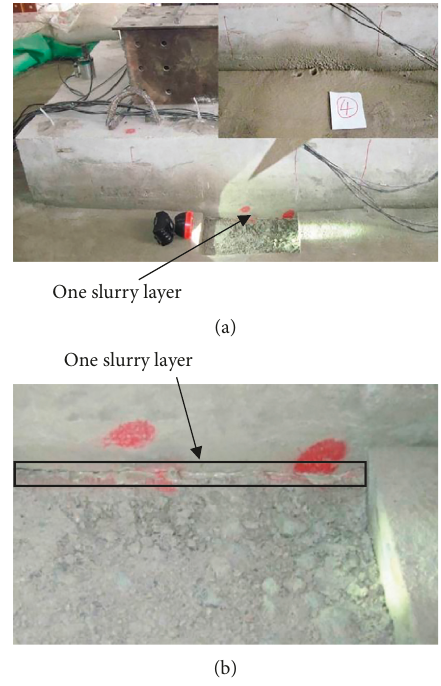
Figure 6: The internal characteristics of mud pumping between the subgrade bed and the concrete